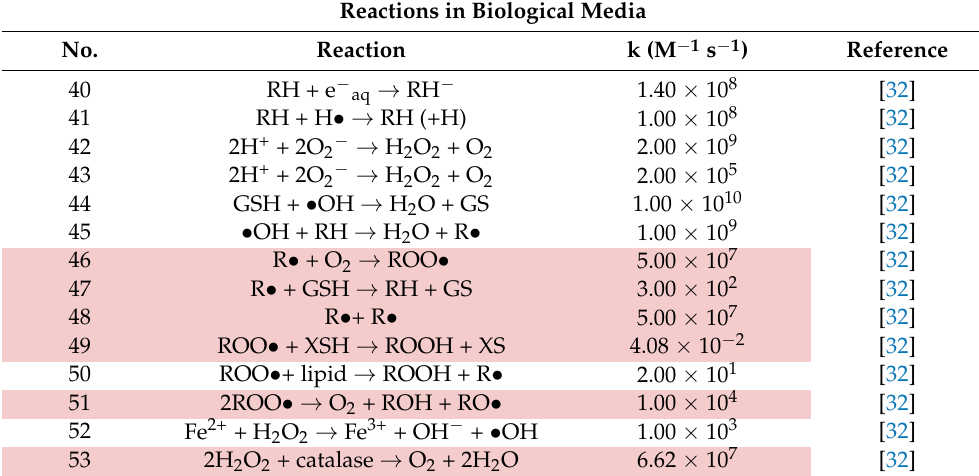
Table 6. Reaction set used in the simulation of the chemical and biological stages for the radiolysis in biological media [32] and associated rate constants. Concentrations for the different elements considered in the cell media are [RH] = 1 M, [GSH] = 6.5 mM, [Fe 2+ ] = 0.89 µ M, [lipid] = 1 µ M, [catalase] = 0.08 µ M [32]. Reactions whose suppression in the simulation contributes more than 1% to the relative change in the final AUC-ROO are highlighted in light red.